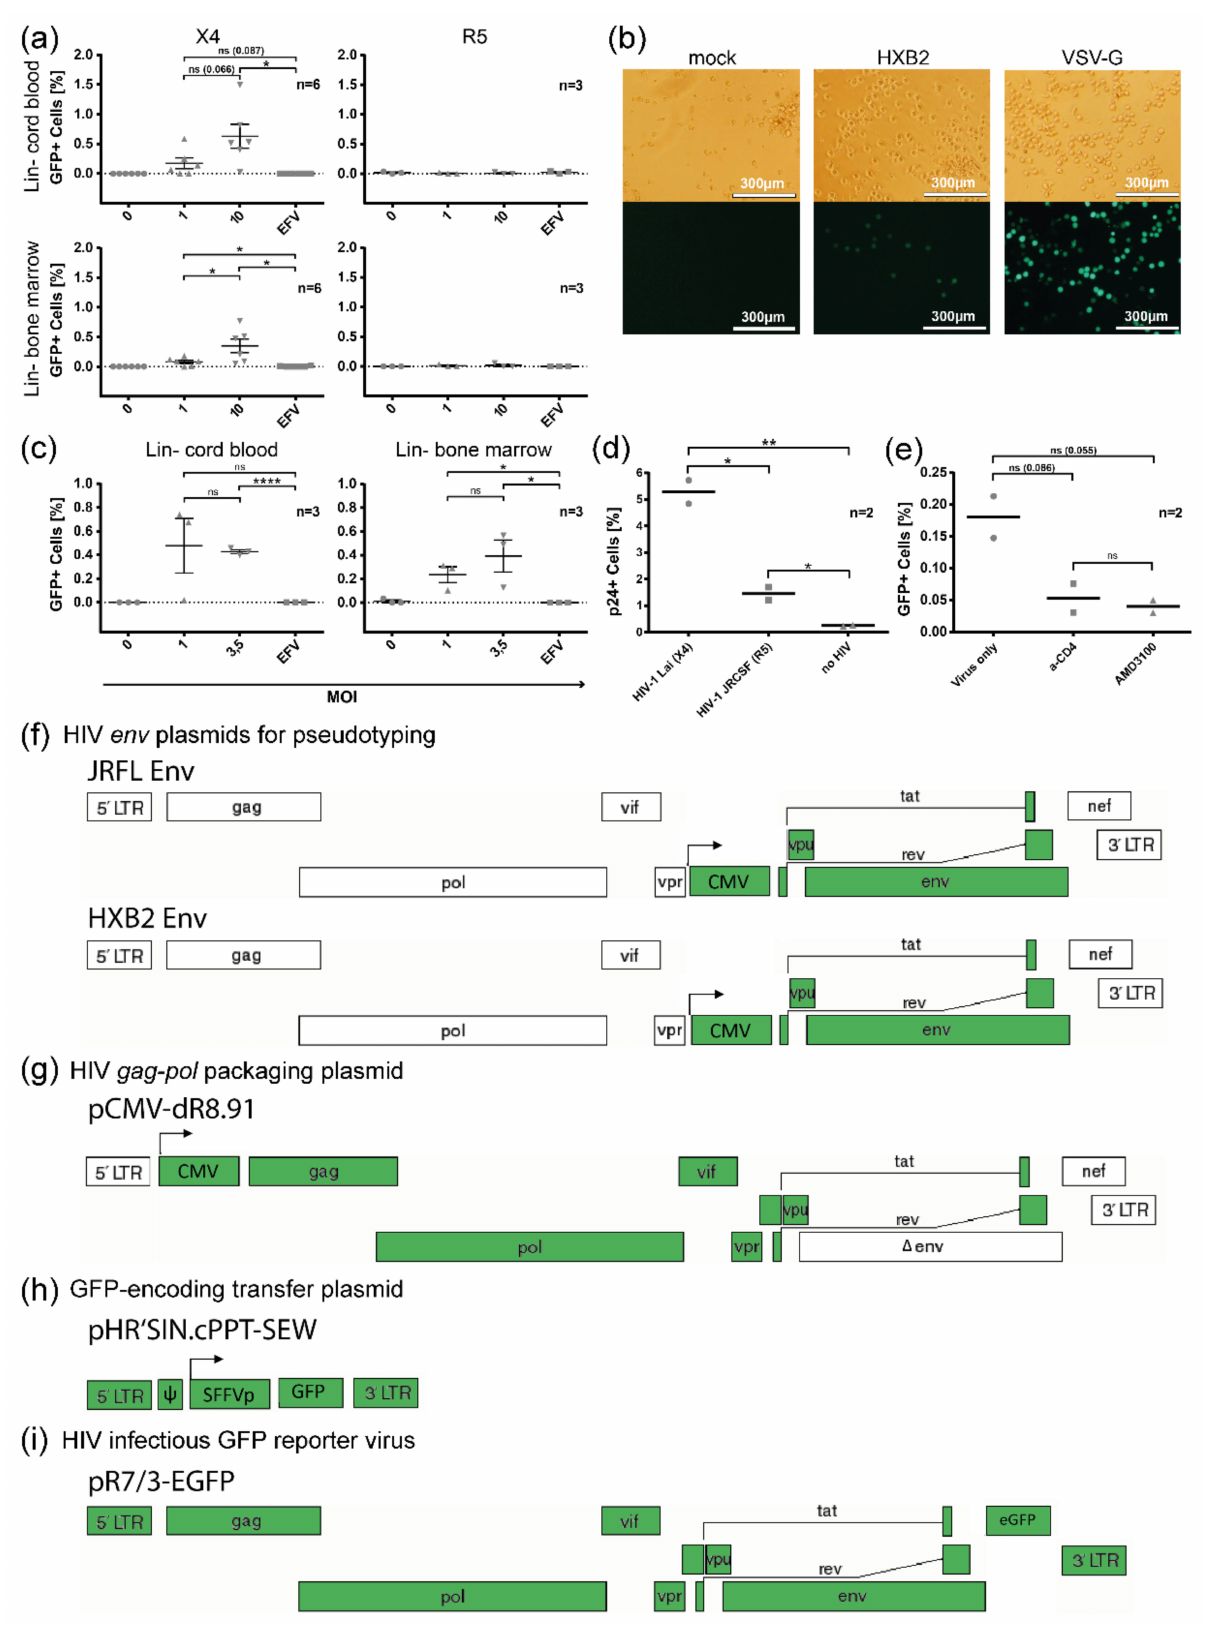
Figure 1. Susceptibility of cord blood and bone marrow-derived HSPCs to transduction with HIV-1 Env-pseudotyped reporter viruses as well as infection with replication-competent reporter